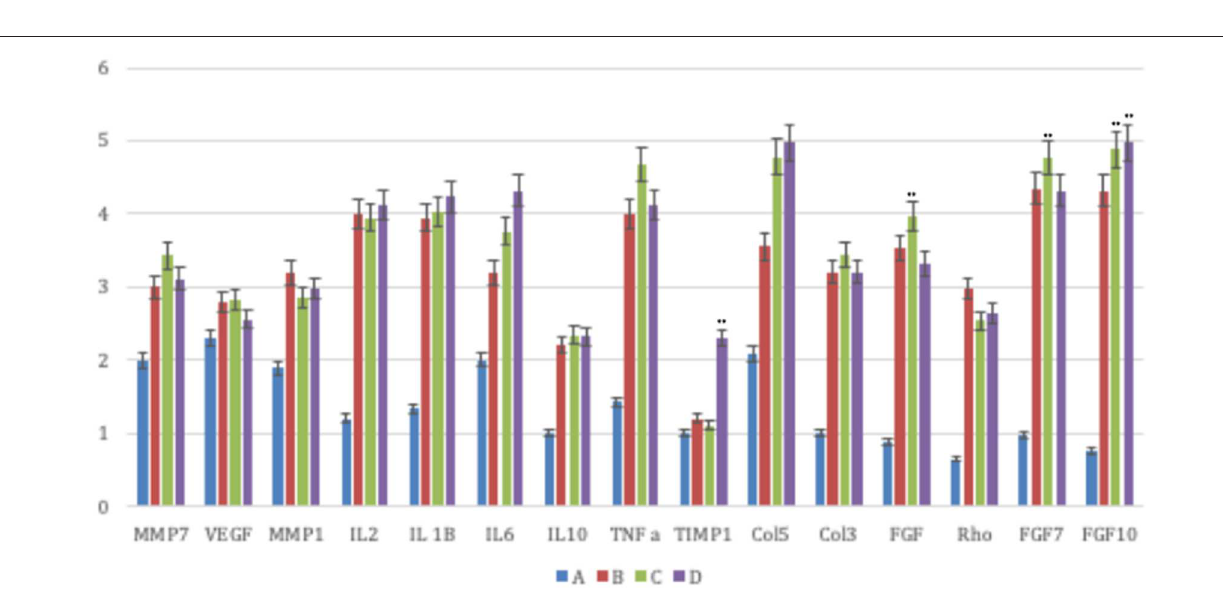
FIGURE 5 | The principal molecules involved in the wound healing process were investigated by means of a real-time PCR array analysis in all groups (Group A: control lesions; Group B: 16 mg/ml talc injection; Group C: 160 mg/ml talc injection; Group D: 300 mg/ml talc injection) at 4 weeks. Regarding the ECM components, the treated samples showed a greater expression of collagens (type 5 and 3 mRNA) compared to control. Concerning the remodeling enzymes, all matrix metalloproteinases (MMPs) displayed a significant increase. Concerning the inflammatory cytokines the treated samples exhibited a greater expression